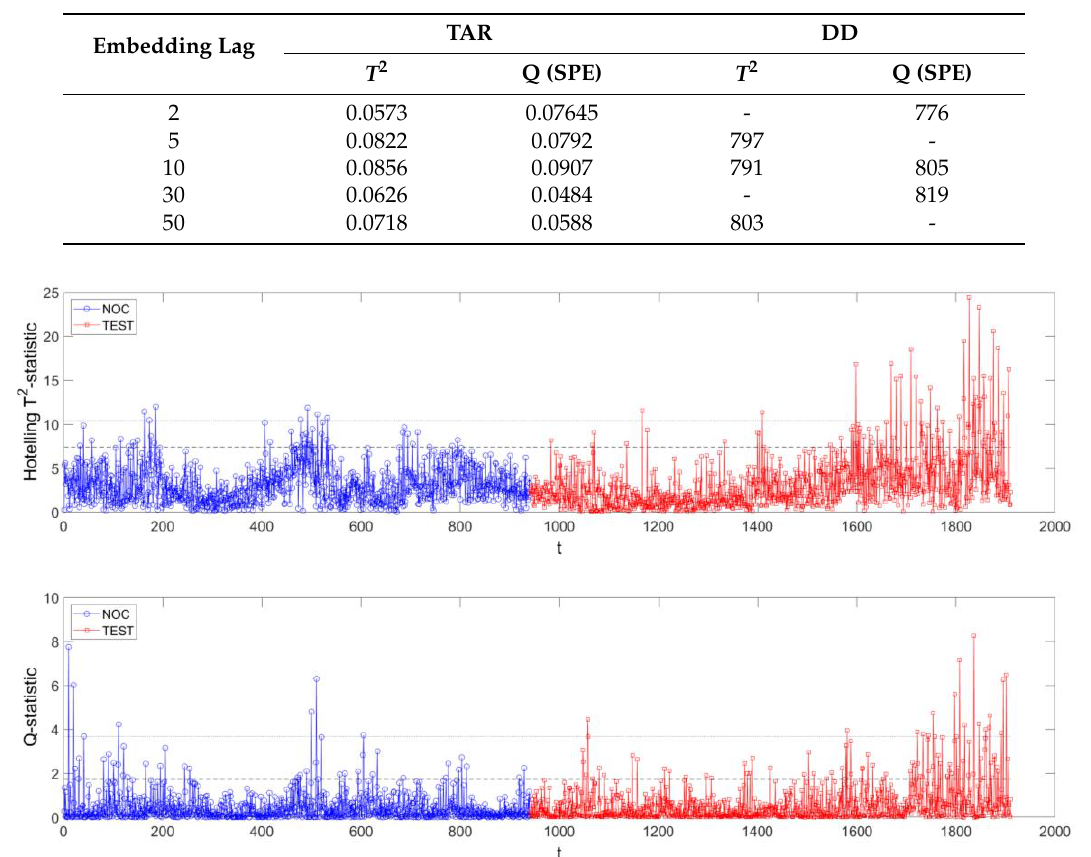
Figure 22. Fully autogenous grinding circuit flow diagram.